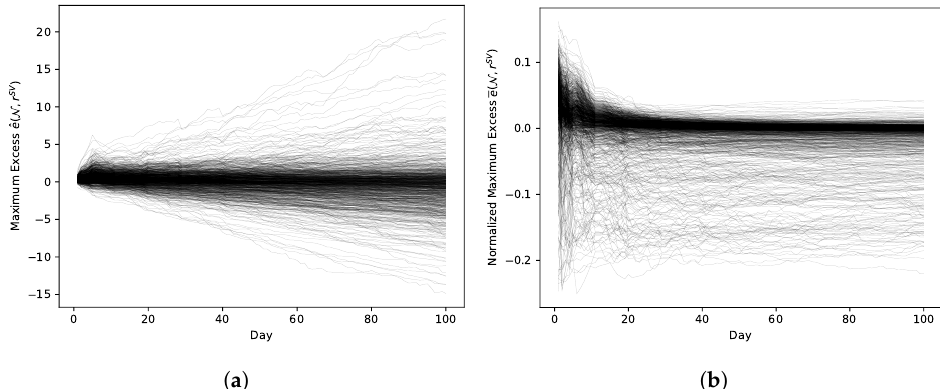
Figure 3. Progress of maximum excess ( a ) and normalized maximum excess ( b ) with Shapley value for 1000